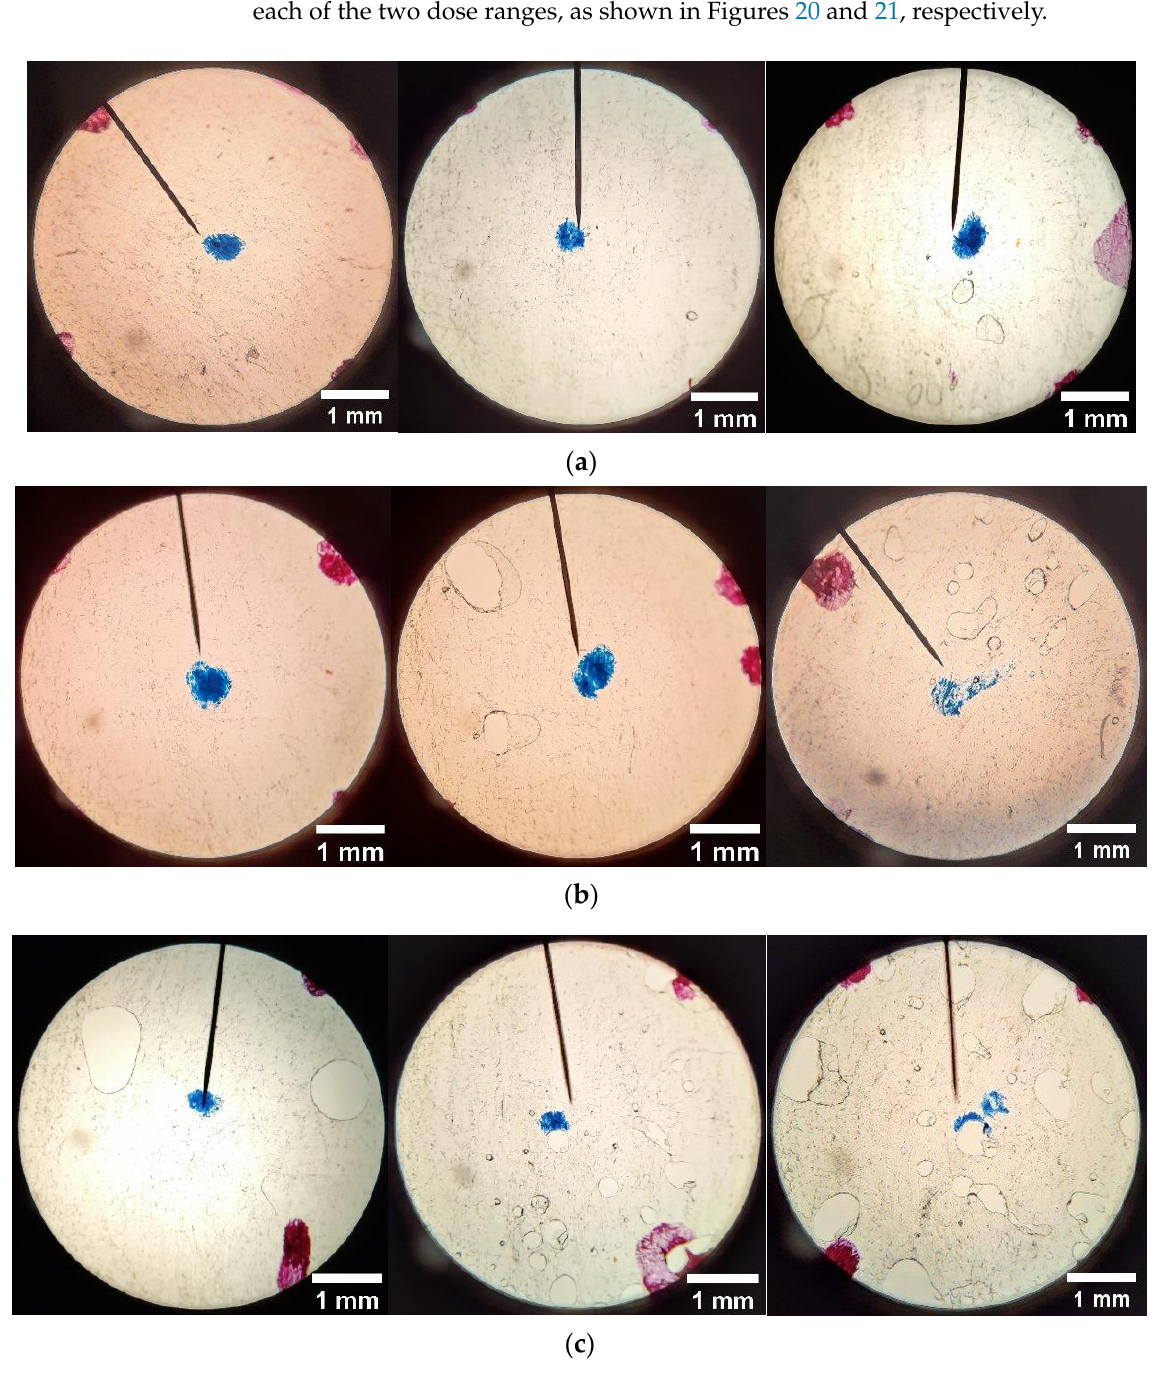
Figure 20. Typical microscopic images (40×) for ( a ) 0 kGy; ( b ) 7.0 kGy; ( c ) 11.2 kGy. Hot Press conditions: 6228 N, 232 °C, 5 min.